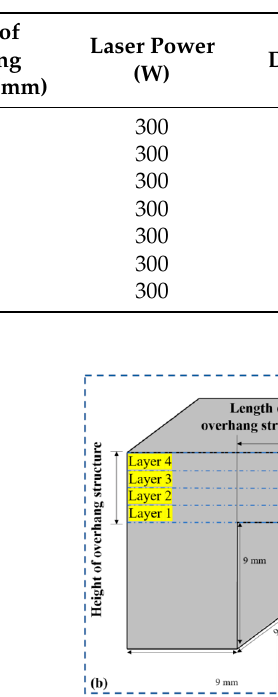
Table 2. Experimental design for different lengths of overhang structure.